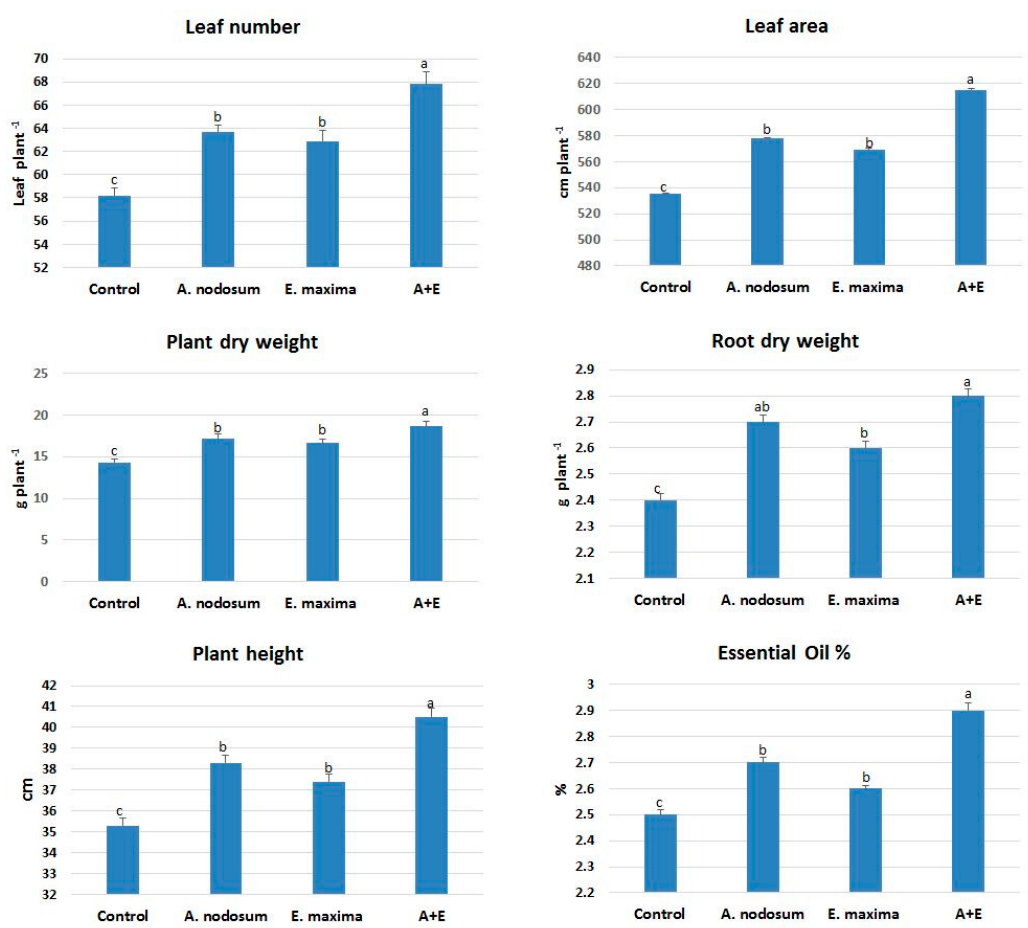
Figure 1. Morphological parameters and essential oil ratio in treated plants. A + E: A. nodosum + E. maxima. Different letters on each column indicate significant different at p ≤ 0.05.